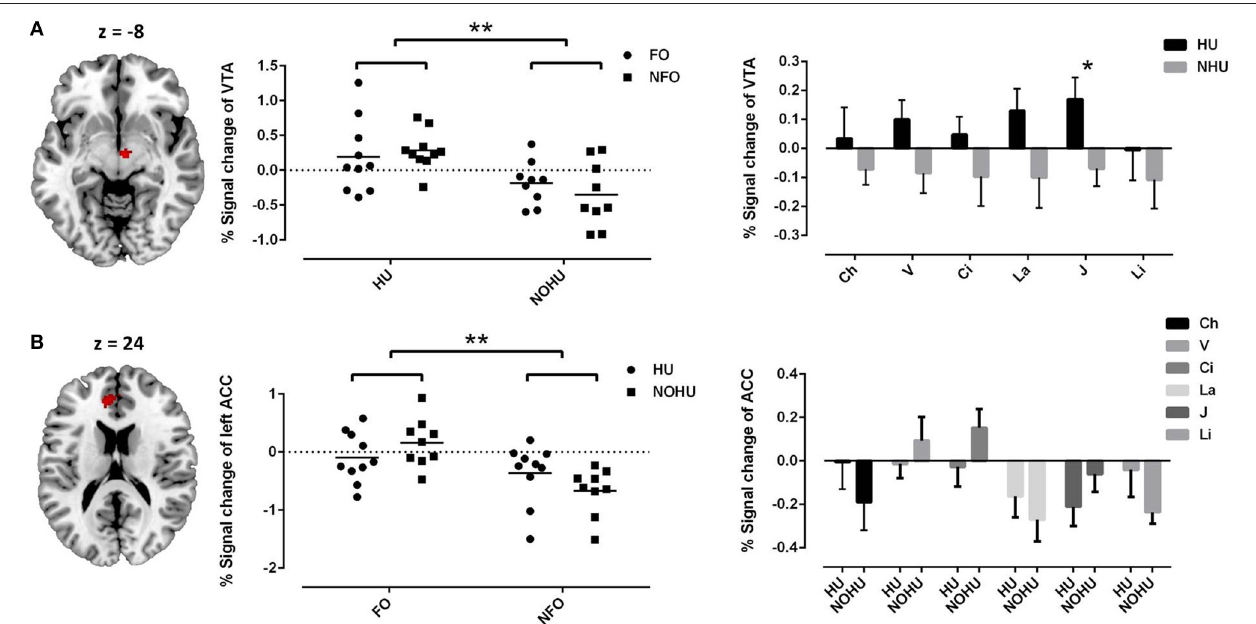
FIGURE 2 | (A) VTA activation represents the main effect of hunger; The mean signal change for FO or NFO group and for individual odors of HU and NOHU participants are shown as a scatter plot (individual data and mean) and bar chart (mean and standard error of the mean), separately; (B) left ACC activation represents the main effect of odor type (FO vs. NFO). The mean signal change for FO or NFO group and for individual odors rated by HU and NOHU participants are shown as the scatter plot (individual data and mean) and bar chart (mean and standard error of the mean), separately; ACC, anterior cingulate cortex; VTA, ventral tegmental area. FO, Food Odors; NFO, Non-food Odors; HU, Hunger group; NOHU, Non-hunger group; V, Vanilla; Ci, Cinnamon; La, Lavender; J, Jasmine; Li, Lily of the Valley. Asterisks indicate significant differences: * p < 0.05; ** p < 0.01.